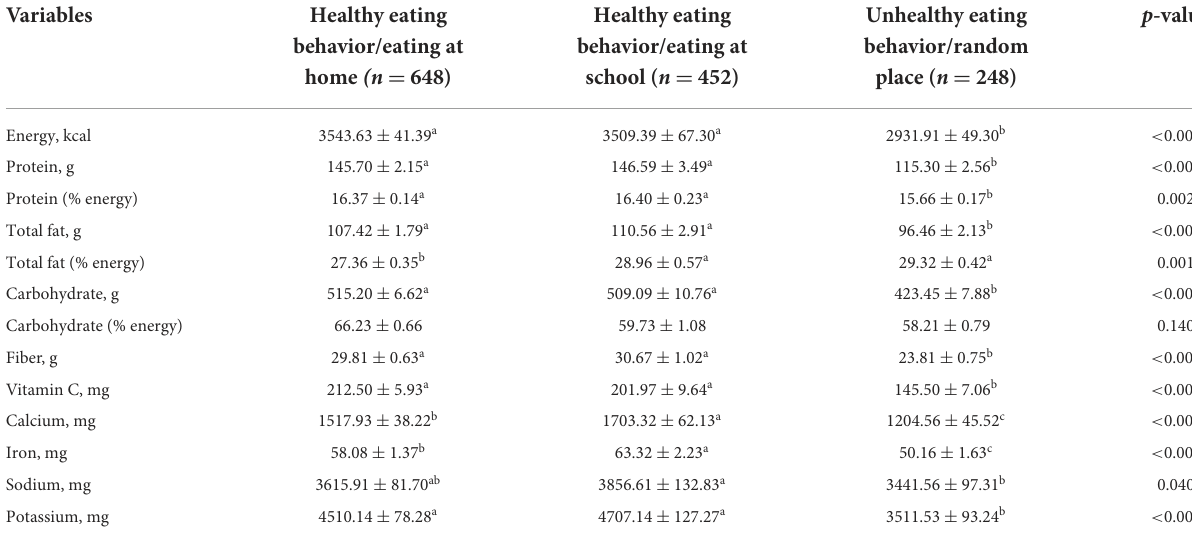
TABLE 7 Comparison of energy and nutrient intakes by latent classes.